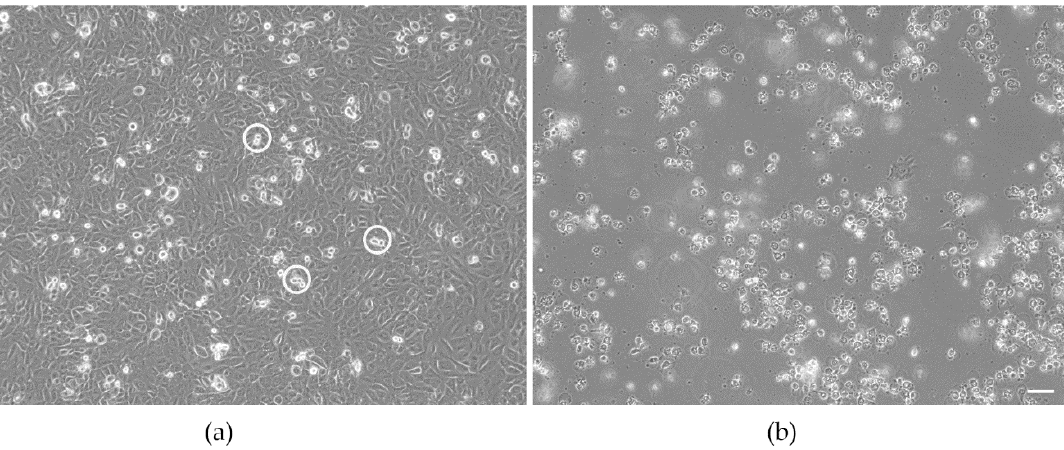
Figure 2. Morphology of untreated EAhy 926 endothelial cells ( a ) and cells exposed to the positive control 20 nm plain polystyrene particles ( b ) after 24 h of culture. Cultures of the untreated EAhy 926 endothelial cells have formed a confluent monolayer with occasional dividing cells (indicated by circles). Cells exposed to the positive control do not form a monolayer but have rounded up, detached from the growth substrate, and float in the medium. Scale bar: 50 µm.